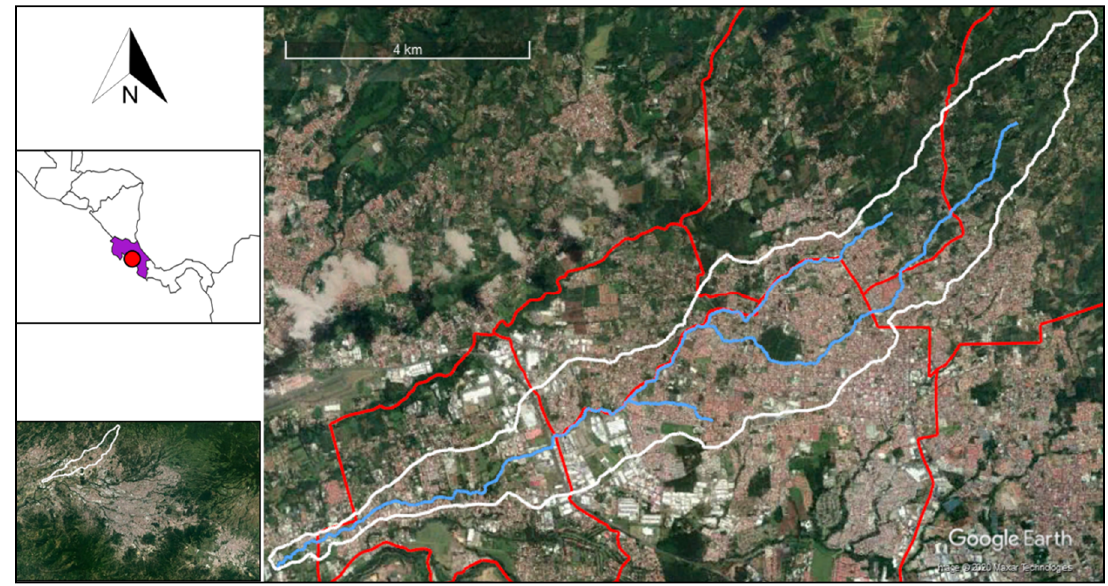
Figure 1. Overview of the Great Metropolitan Area (bottom-left) in Costa Rica and location of the Quebrada Seca-Río Burío Watershed including municipality boundaries (red lines), river network (blue line) within the watershed divide (white line).